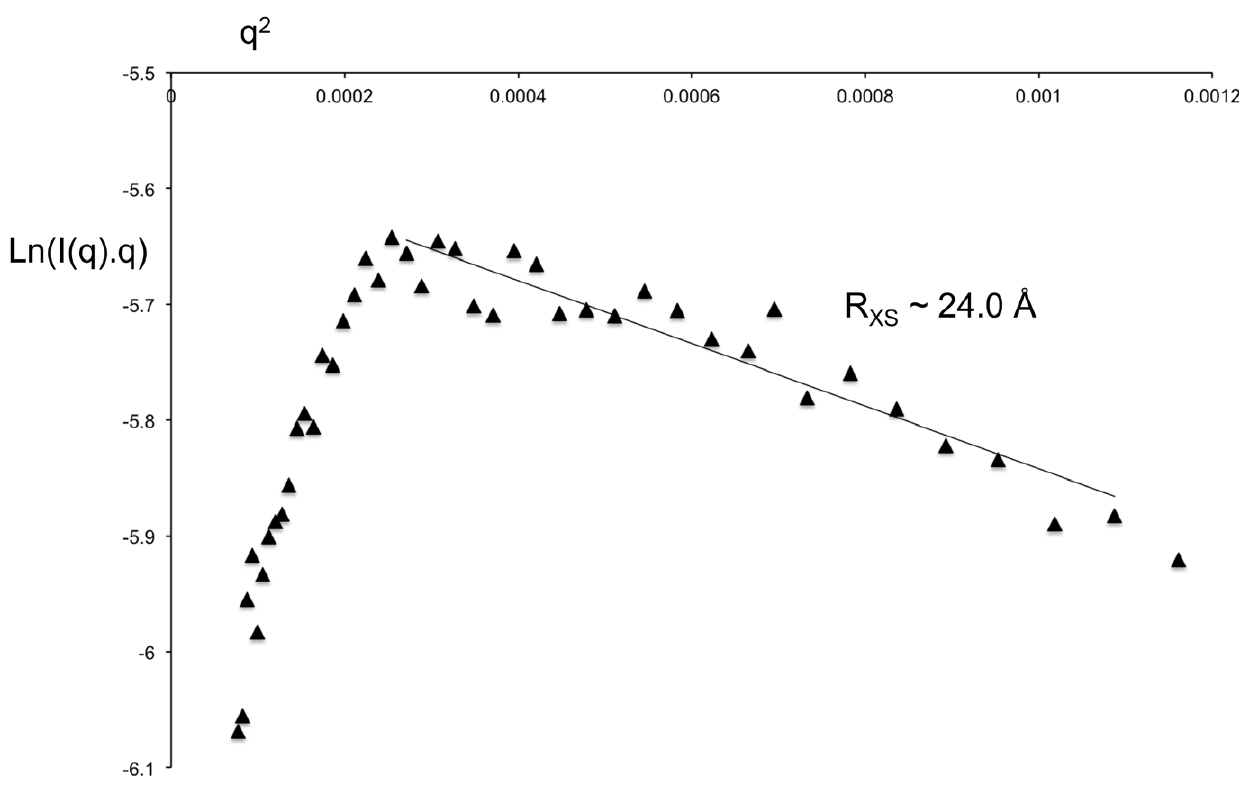
Figure 5. The modified Guinier plot (ln(q.I(q)) versus q 2 , I in cm 2 1 , q in A˚ 2 1 ) of the ‘‘73.5% D 2 O’’ dataset. The R XS and mass/length of the protein segment were obtained from the slope and the intercept of this plot.